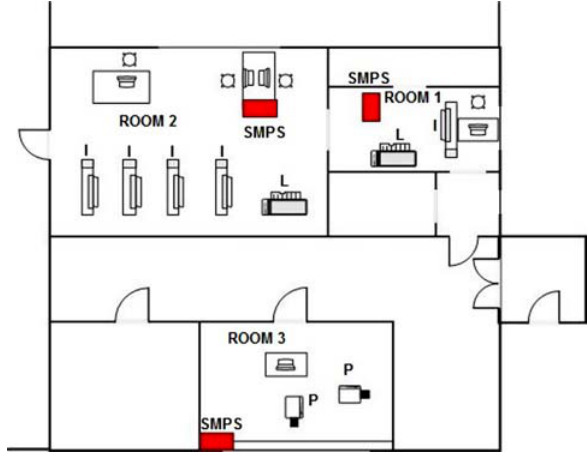
Figure 1: Schematic illustration of three investigated working rooms in a company for spatial informatics and graphic design in Ljubljana, Slovenia with denoted positions of SMPS in each room as well as printers and copiers. L: laser printer, P: photocopy mac- hine and I: inkjet